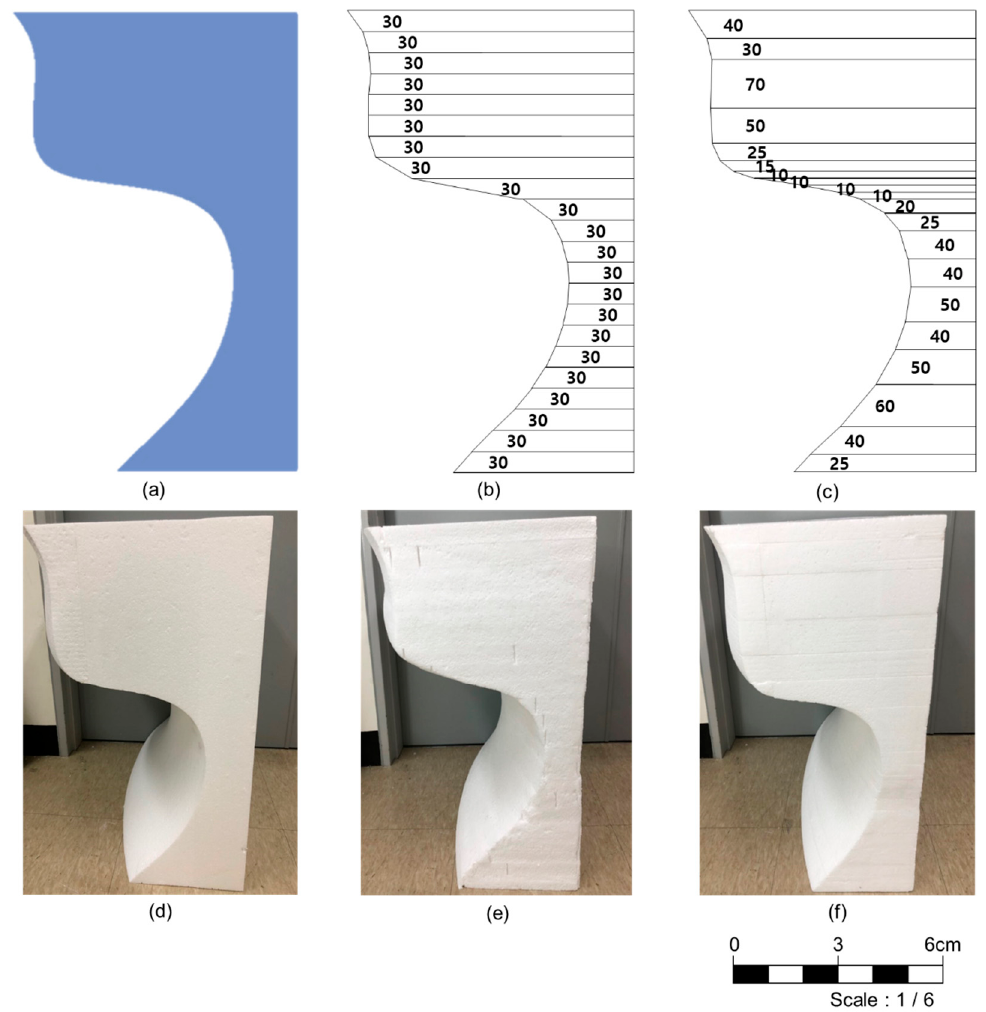
Figure 6. Schematic and picture of manufacturing results; ( a ) Original shape (side); ( b ) uniform slicing by thickness of 30 mm; ( c ) adaptive slicing with error tolerance ( e t ) of 2 mm; ( d ) CNC milling; ( e ) uniform slicing; ( f ) adaptive slicing.